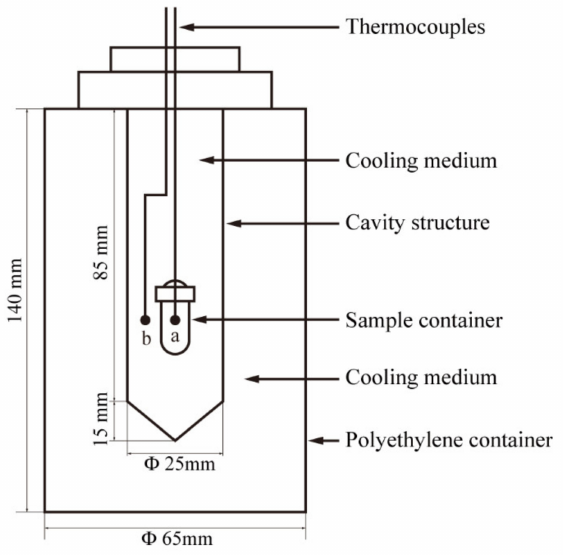
Figure 2. Schematic diagram of cooling system for the E. coli inoculated